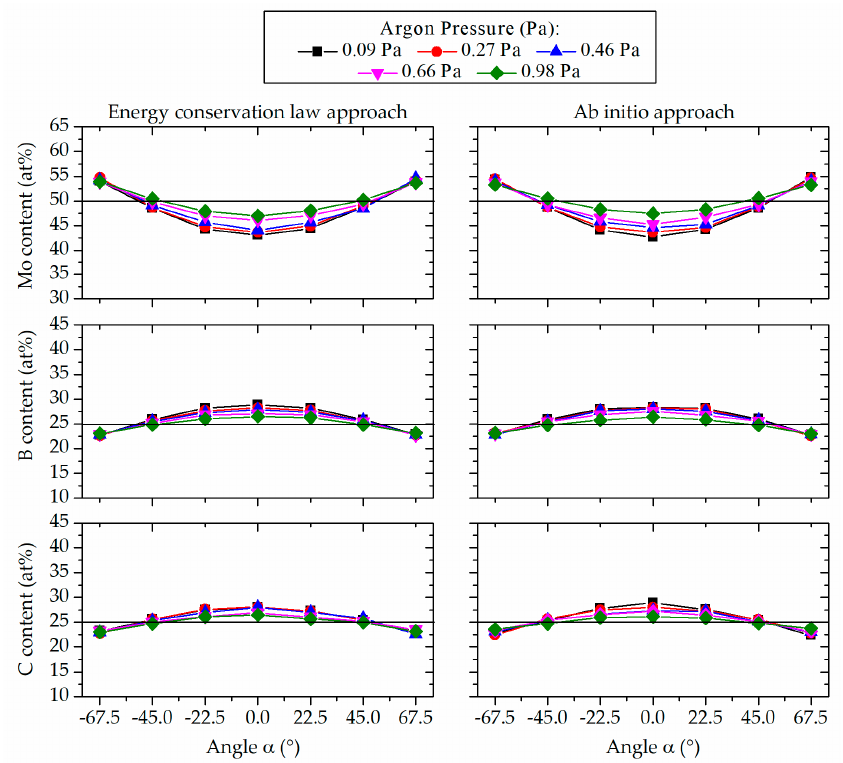
Figure 5. The simulated angle-resolved composition of thin films with the Ar pressure range from 0.09 to 0.98 Pa. Considered surface binding energies of the two approaches ( left ) energy conservation law and ( right ) ab initio. The ideal stoichiometric target composition is marked by the black horizontal lines.